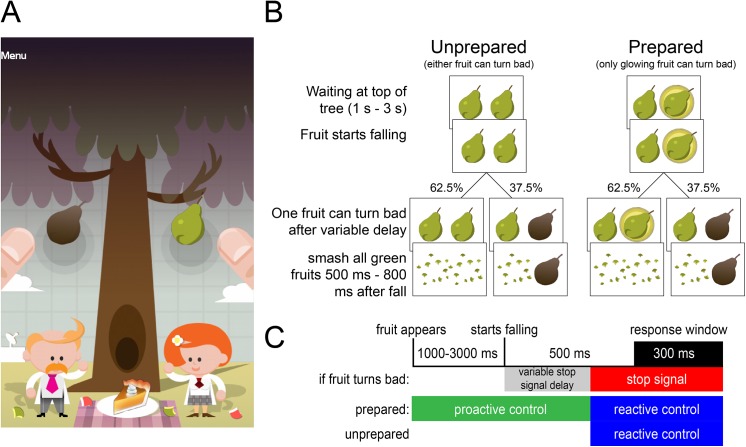
Task design.(A) The game required participants to smash fruits as they passed over the gray circles. (B) On 37.5% of trials one of the fruits turned brown in mid-flight, prompting the participant to quickly withhold their response only on that side. On Unprepared trials either fruit could turn bad (the example in B shows the fruit on the right turning bad). On Prepared trials one of the fruits glowed, indicating that only that fruit could turn bad. (C) This information could be used to employ proactive control, and we quantified proactive control as the improvement in performance in Prepared over Unprepared trials.